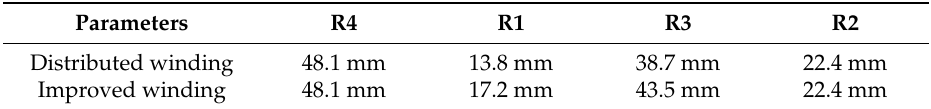
Table 1. Physical dimensions of both PCB windings. R1, stator inner radius; R2, effective conductor inner radius; R3, effective conductor outer radius; R4, stator outer radius.